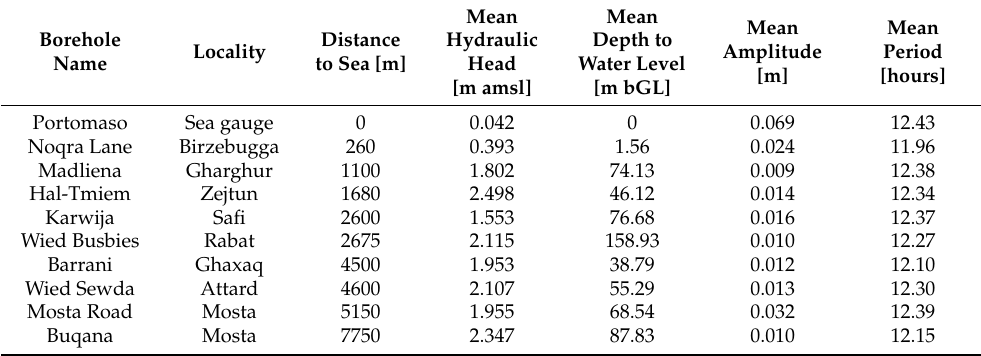
Table 1. Average values of analysed monitoring boreholes during the period of analysis (from 1st May until 31st July 2011).